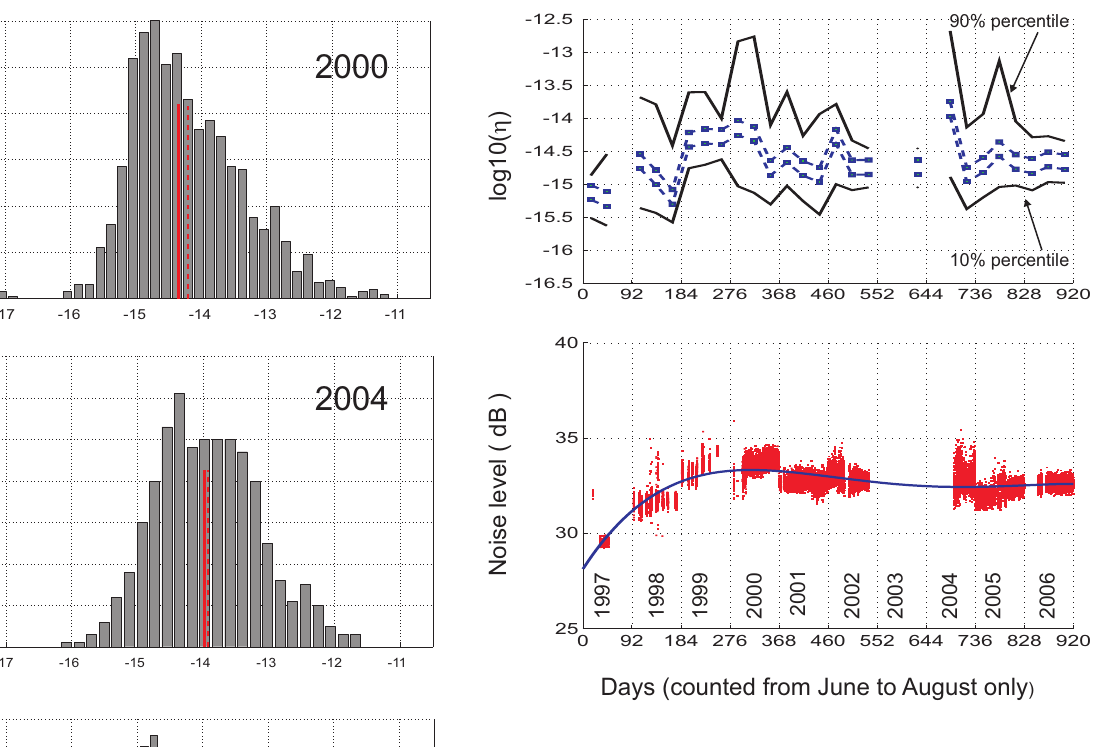
Fig. 6. The recorded backscatter cross-section values for a period of ten years at Resolute Bay (upper panel). The two dash-dash lines show the calculated medians of two backscatter cross-section dis- tributions based on the lowest and highest system efficiency values. The two solid black lines refer to the 90th and 10th percentile values of the two distributions. The lower panel shows the noise variations at the radar site. The days are counted from 1 June to 31 August each year. The gaps refer to missing